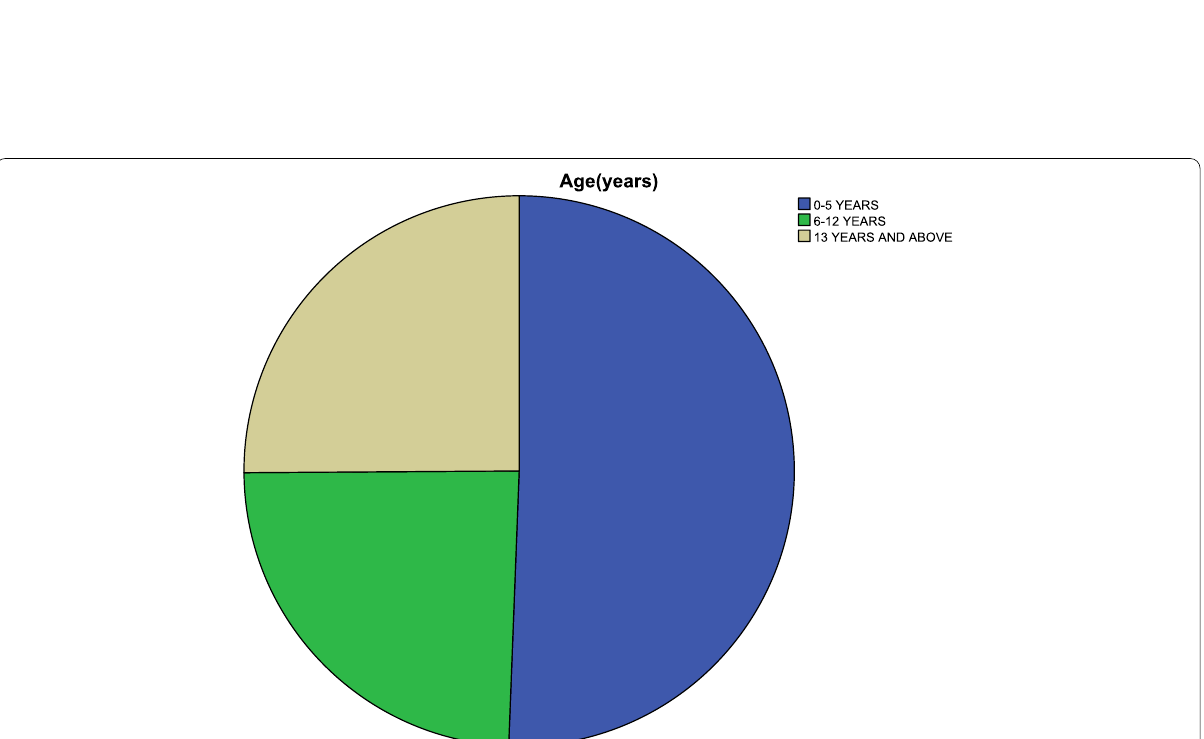
Fig. 4 Distribution of hemoglobinopathies among patients investigated at Aga Khan Hospital, Kisumu, and its satellite centers in Western Kenya based on age